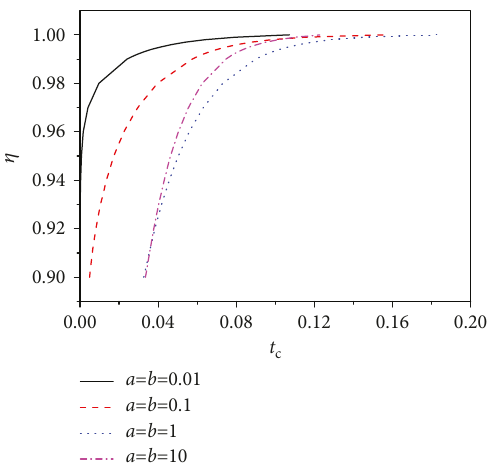
η in cases with same c with